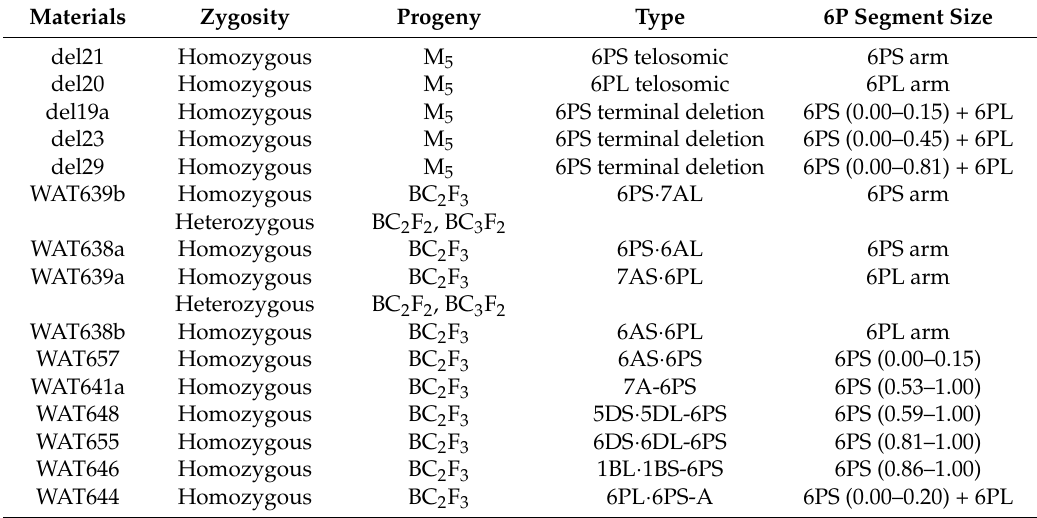
Table 4. The detailed information of plant